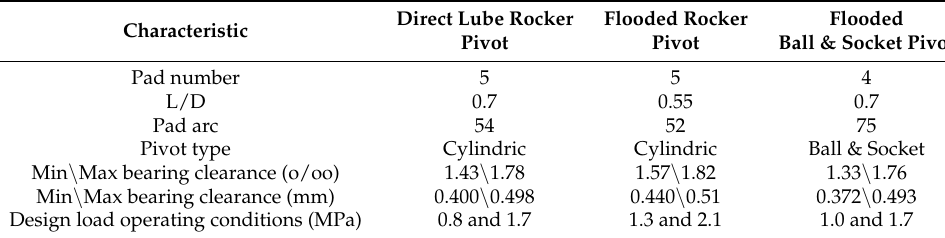
Figure 5. Tested bearings: ( a ) Direct Lube Rocker Pivot, ( b ) Flooded Rocker Pivot, ( c ) Flooded Ball & Socket Pivot. © 2020 Baker Hughes Company—All rights reserved. Table 4. Test articles data.